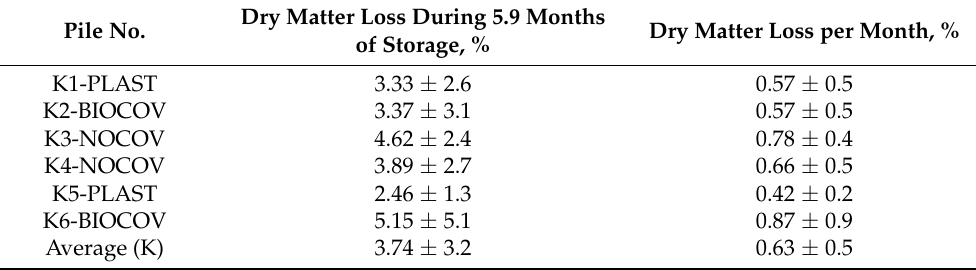
Table 4. Dry matter loss during the Kuopio experiment (K) for the stemwood chip piles with different cover alternatives in average values and standard deviations.